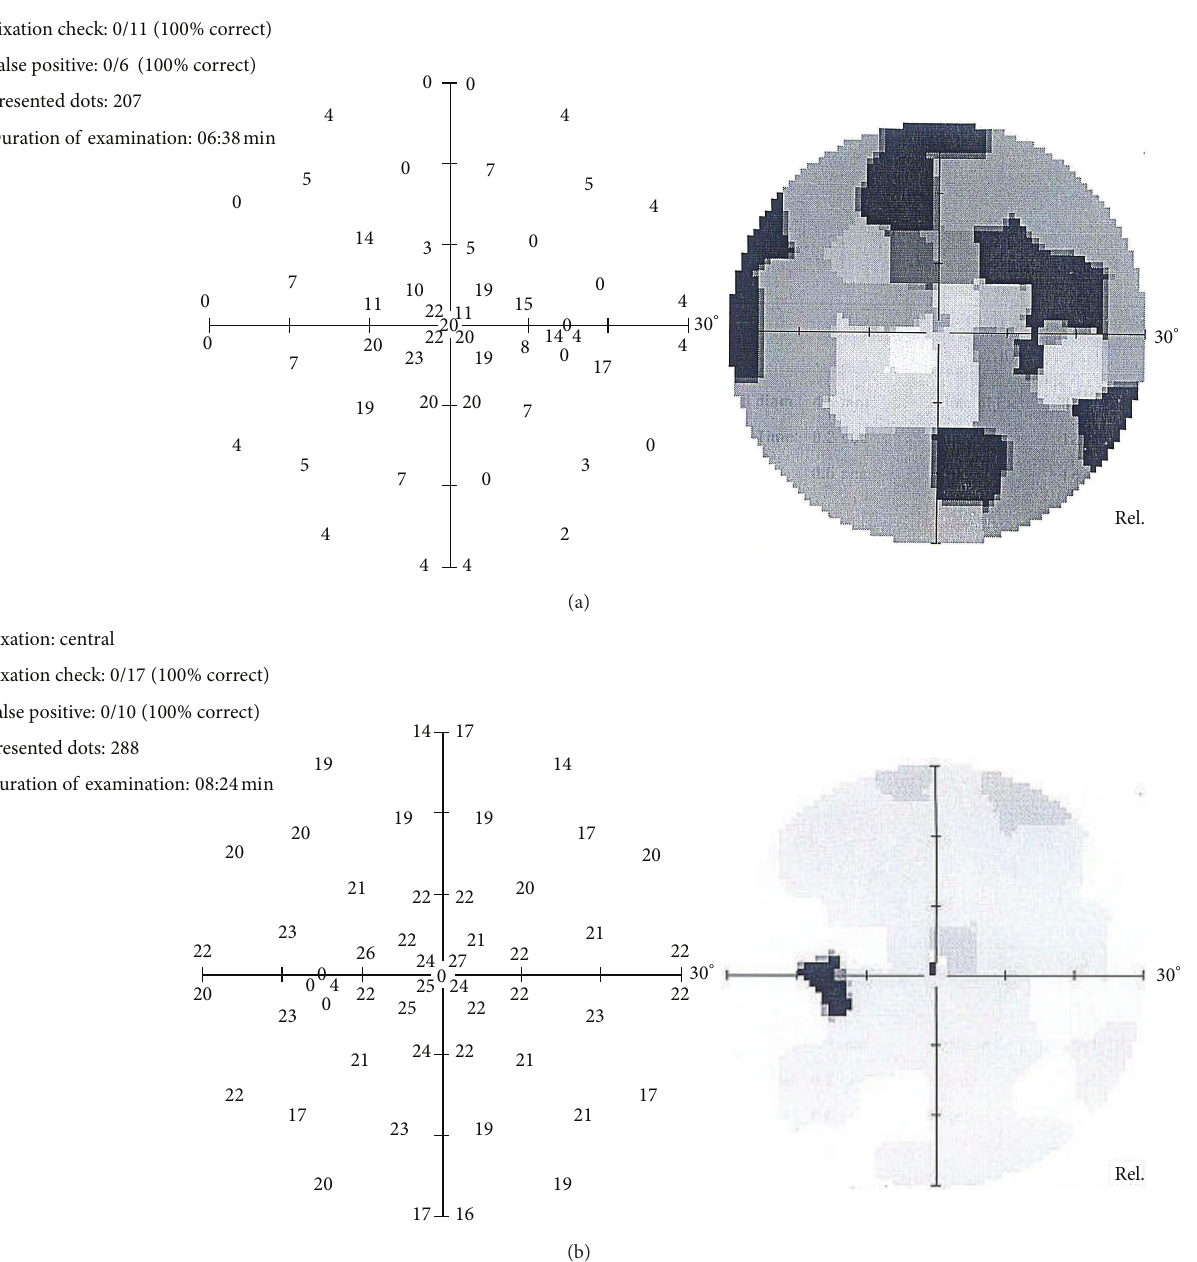
monitoring of the platelet count and thrombophylaxis when necessary after splenectomy, since these patients may present with central retinal vein occlusion besides other severe